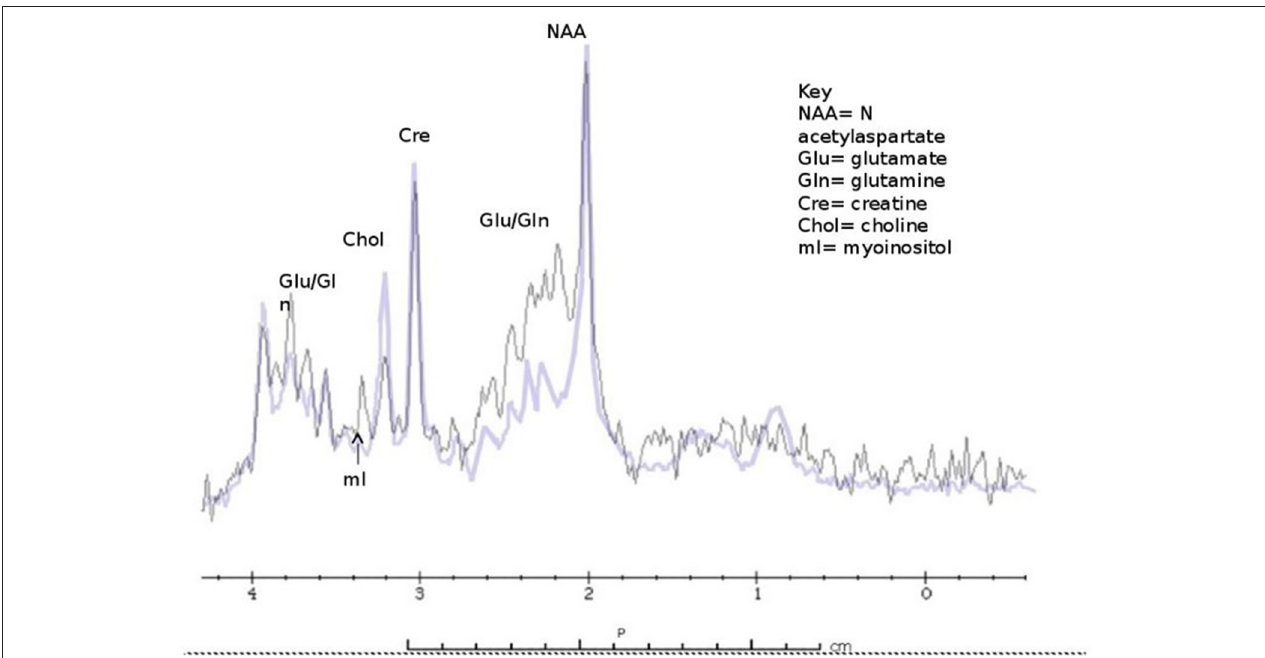
FIGURE 4 | Classic findings of 1H MRS in OTCD - elevated glutamine peak with reduced myoinositol and choline and peaks (purple) compared to normal subject (black).